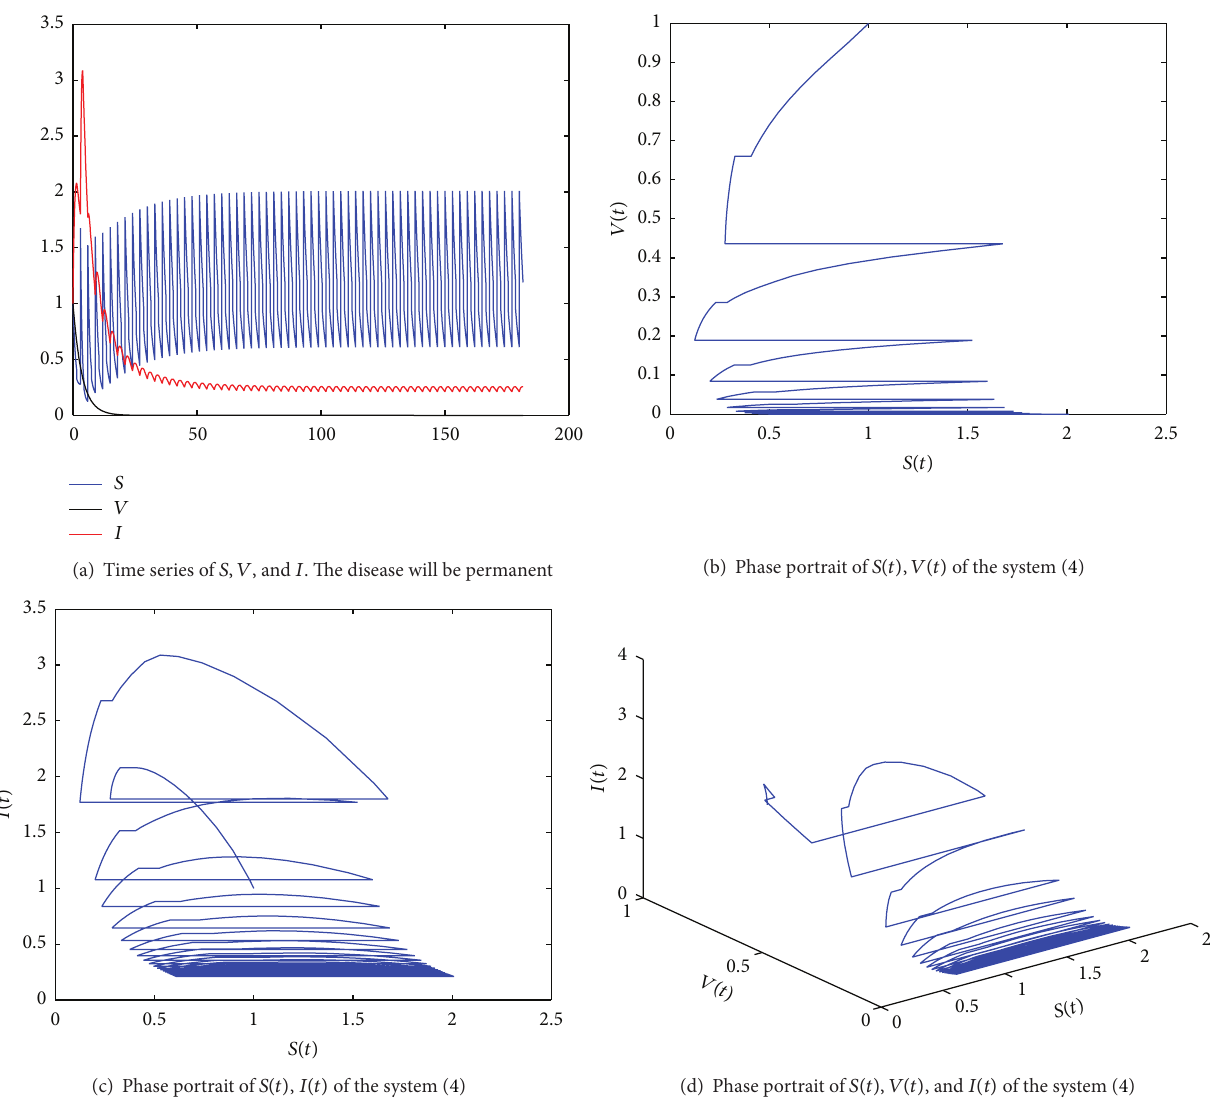
Figure 5: The results of numerical simulation on the threshold values R 2 = 1.1036 > 1 , where 𝑝 = 1.5 , 𝑞 = 1.25